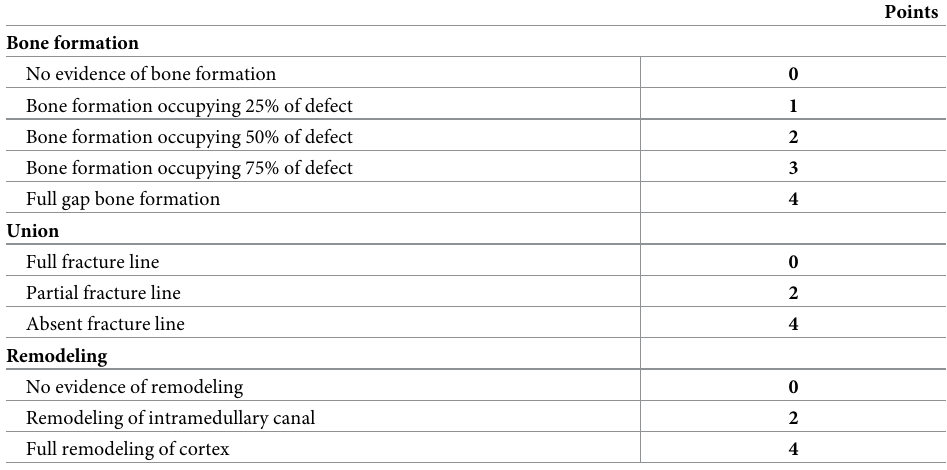
Table 1. Radiographic